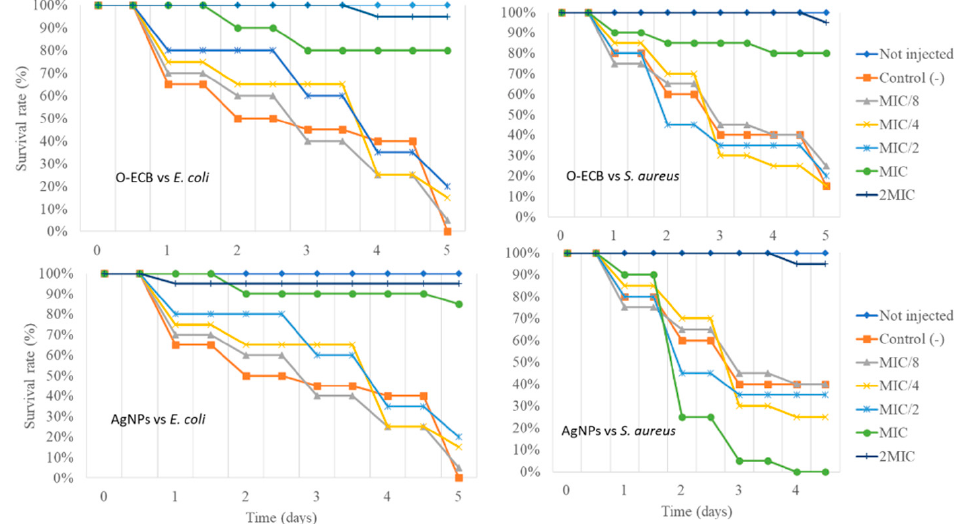
Figure 11. In vivo antimicrobial activity of AgNPs and O-ECB on larval form of Galleria mellonella challenged with S. aureus ATCC 6538 and E. coli ATCC